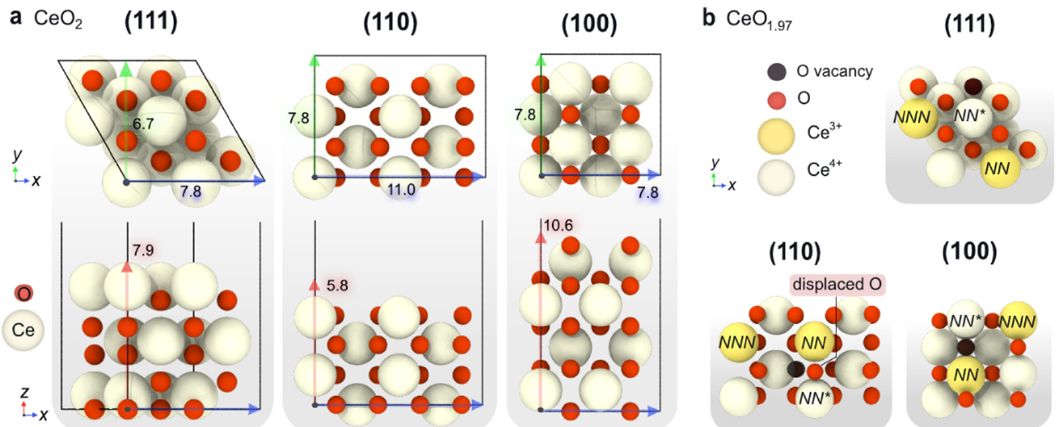
Figure 2. ( a ) Top (above) and side (below) views of the DFT-modeled stoichiometric surface slabs CeO 2 (111), CeO 2 (100) and CeO 2 (110). The slab dimensions are also given (in Å). ( b ) Top view of the non-stoichiometric slabs featuring one O surface vacancy with the polaron localized in the most stable configuration. NN and NNN denote the nearest neighbor and next-nearest neighbor positions with respect to the O vacancy, respectively.